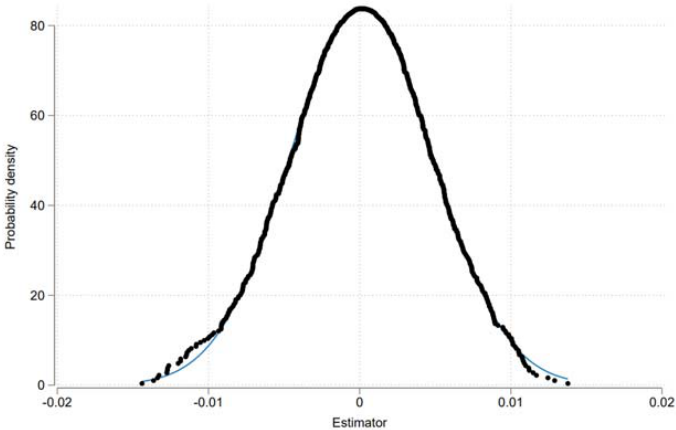
Figure 4. Placebo